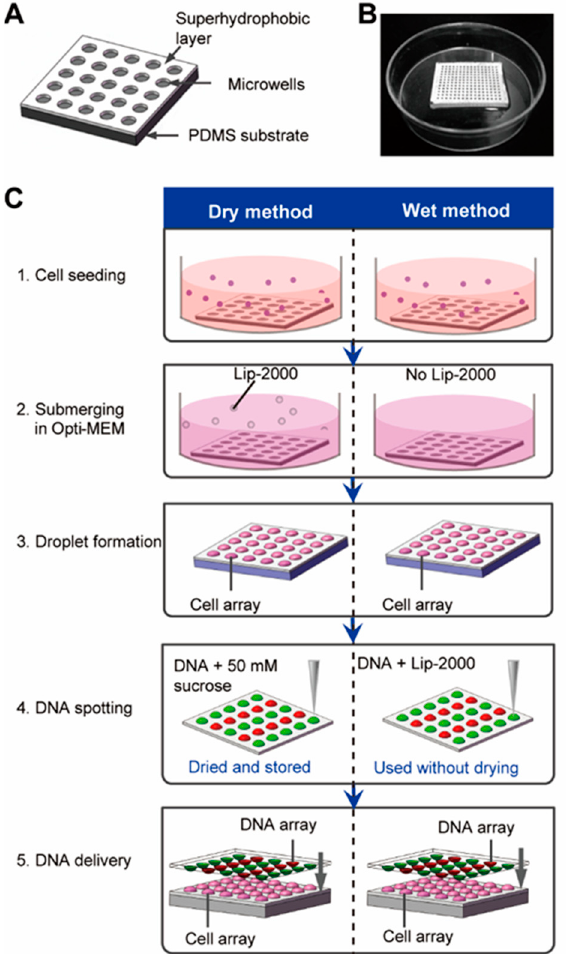
Figure 1. Schematic of the high-throughput transfection on the chip. ( A ) Structure diagram of the superhydrophobic microwell array chip (SMAR-chip). ( B ) Macroscale image of a SMAR-chip with a 13 × 13 microwell array. ( C ) Procedure of the on-chip high-throughput transfection. For the dry method (left), the mixture of DNA and 50 mM sucrose was spotted on the glass slide which can be dried and stored until the time of use, while for the wet method (right) the mixture of DNA and Lipofectamin ® 2000 (Lip-2000) was spotted and used immediately without drying.